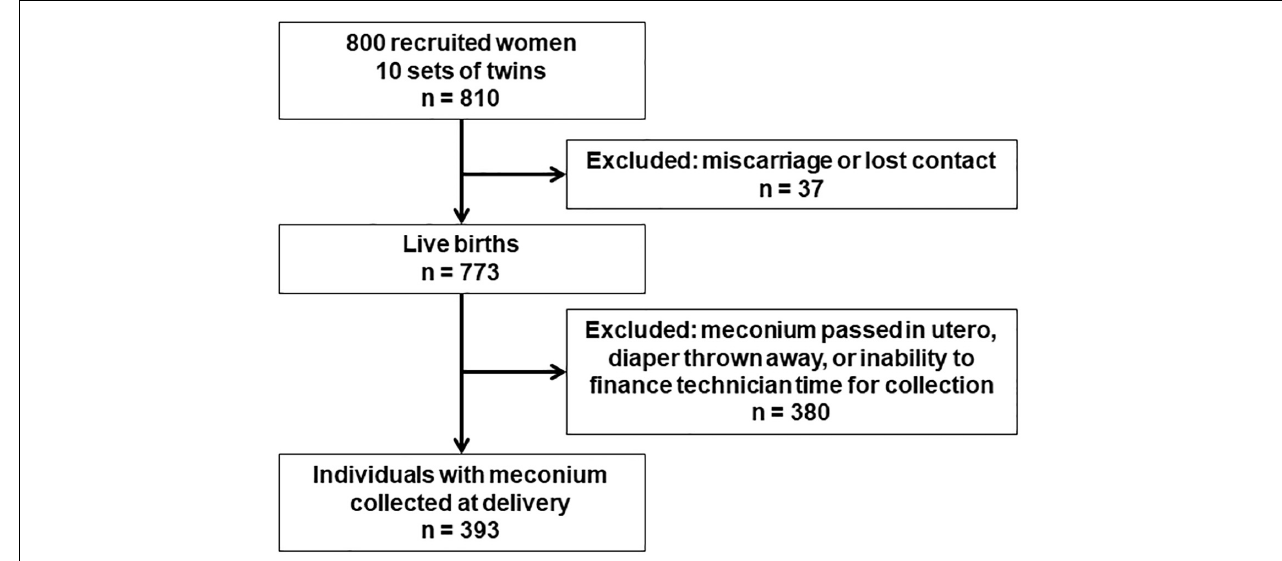
FIGURE 1 | Gestation and the environment (GESTE) cohort